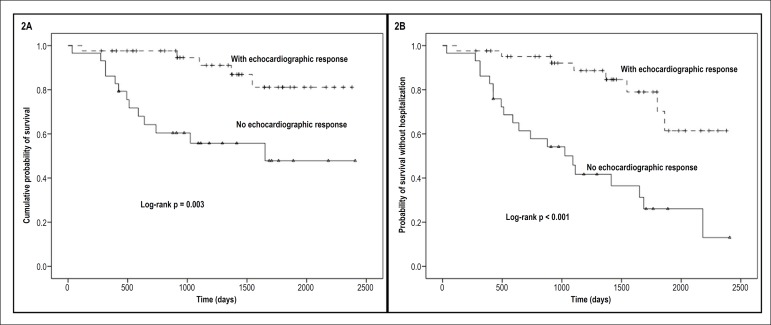
Kaplan-Meyer curve of total mortality (A) and total survival free of
death or hospitalization (B) stratified by ecocardiographic
response.